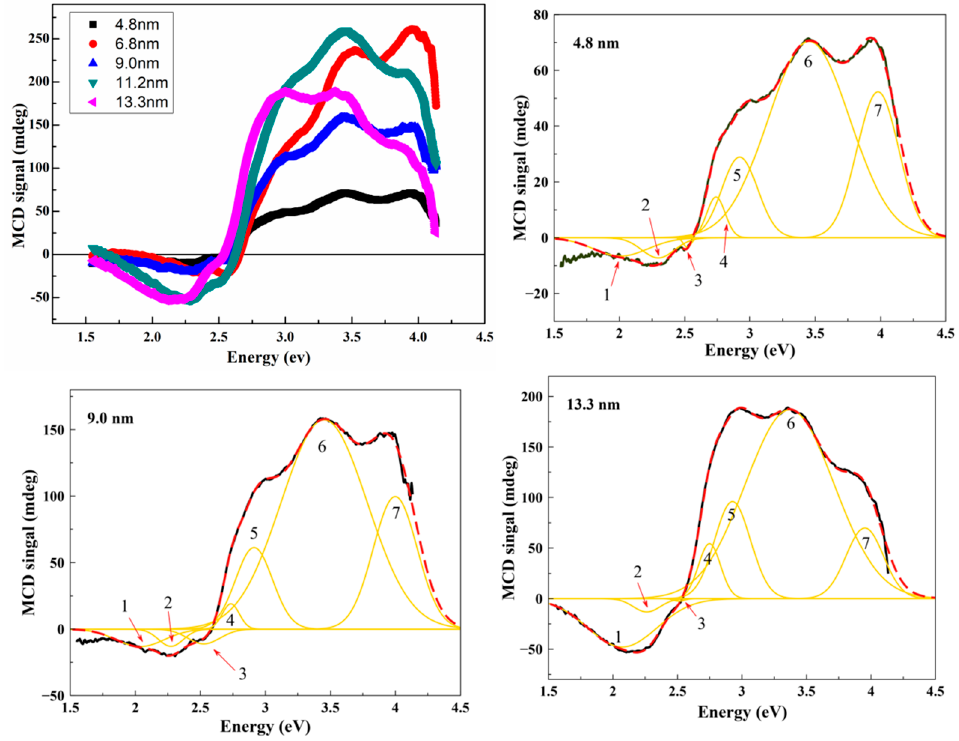
Figure 4. Experimental MCD spectra of the magnetite nanoparticles measured at room temperature and the best Gaussian fitting of the spectra with d = 4.8, 9, and 13.3 nm. Red dotted curves correspond the sum of the deconvoluted spectra.